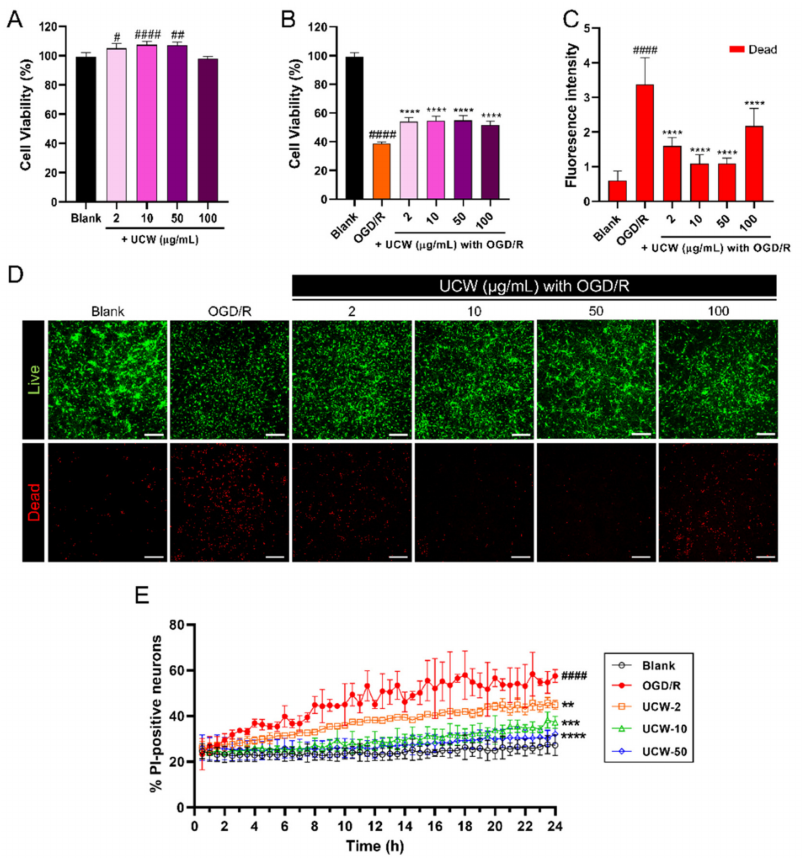
Figure 1. Protective effect of UCW against OGD/R-induced injury in primary cortical neurons. ( A ) Cell viability of primary cortical neurons pretreated with UCW for 48 h without OGD/R